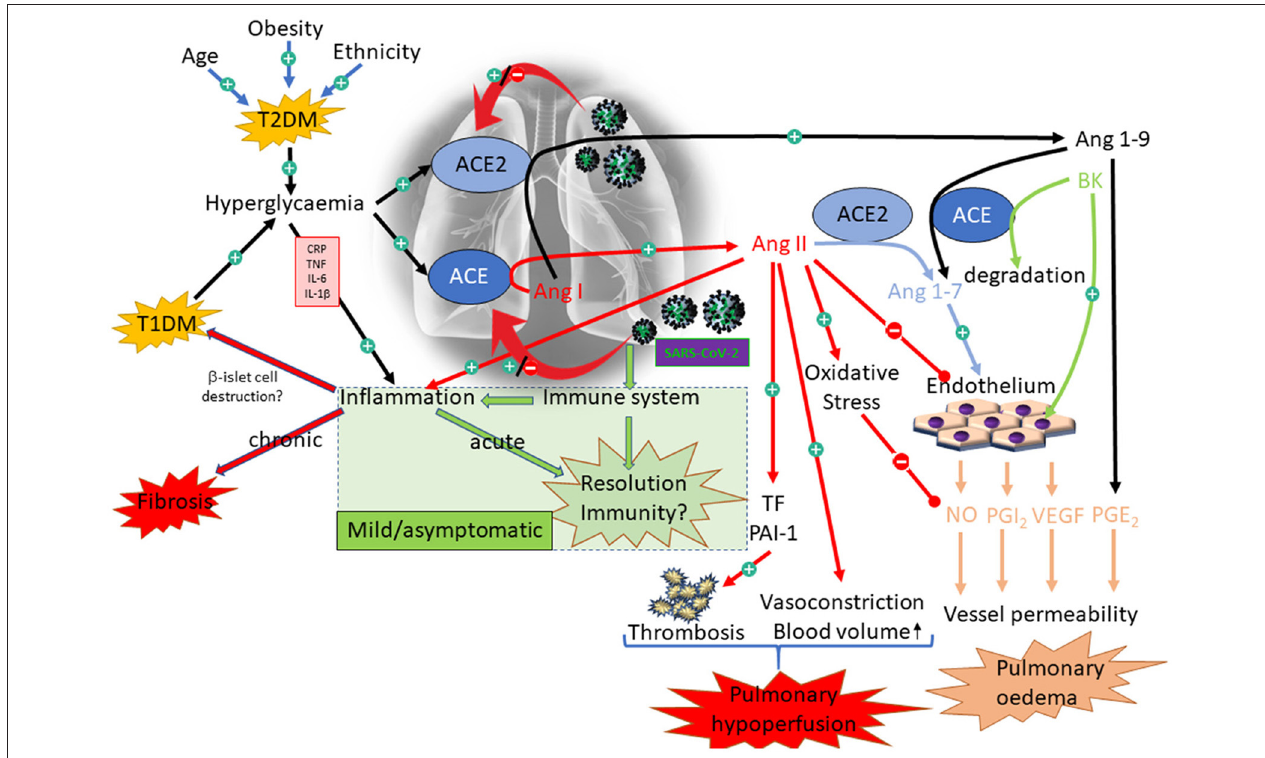
FIGURE 6 | Interaction between diabetes and COVID-19 with respect to the RAAS. Illustration of the complex interactions associated with diabetes and COVID-19. The green box illustrates the appropriate response to SARS-CoV-2, resulting in only mild symptoms. The alternative pathways illustrate some of the dysregulation that might be primed by diabetes, resulting in acute (pulmonary hypoperfusion and oedema) and chronic (fibrosis)